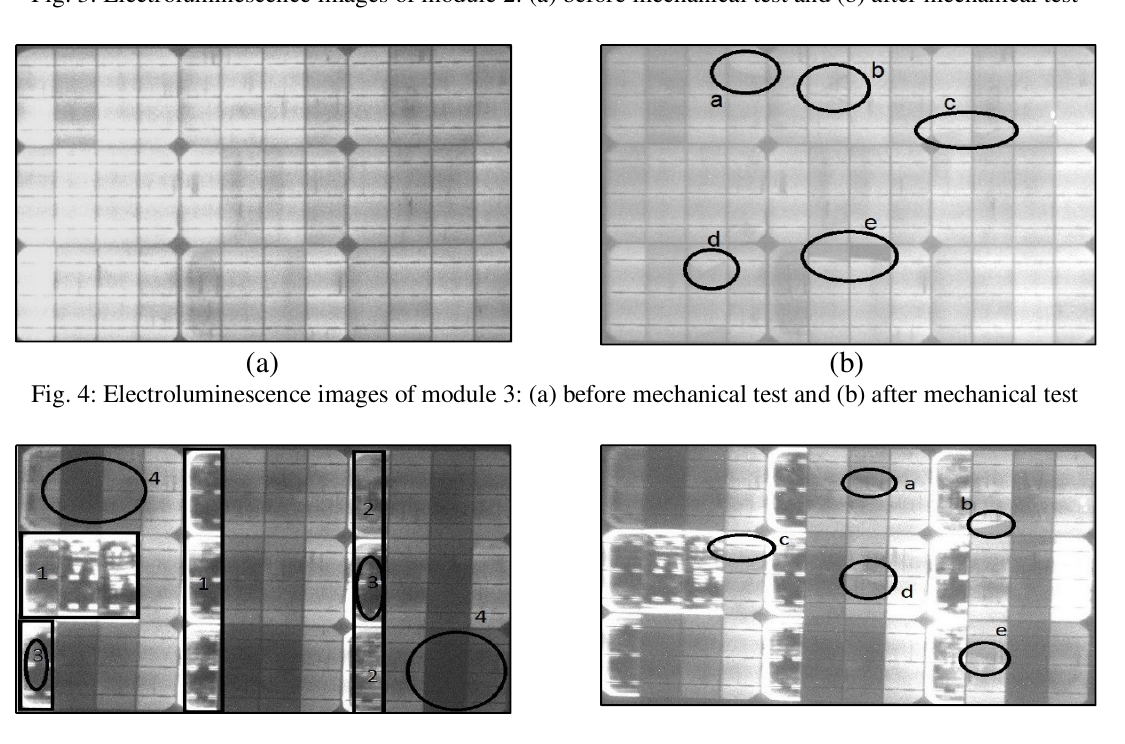
Fig. 3: Electroluminescence images of module 2: (a) before mechanical test and (b) after mechanical test